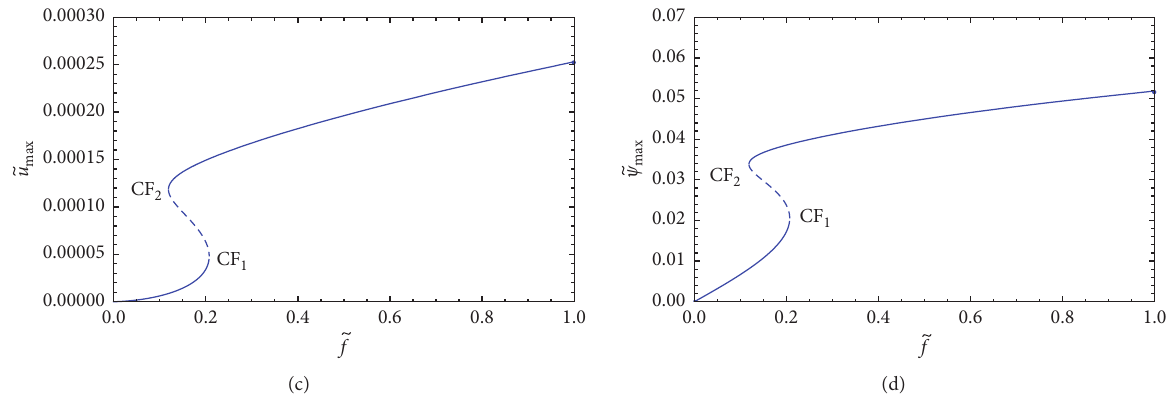
Figure 7: Force-response curves of the coupled motions of SS BDFG porous beam with m 􏽥 Ω � 15. (a), (b) Maximum and minimum amplitudes of transverse motion. (c) Maximum amplitudes of longitudinal motion. (d) Maximum amplitudes of rotational motion.